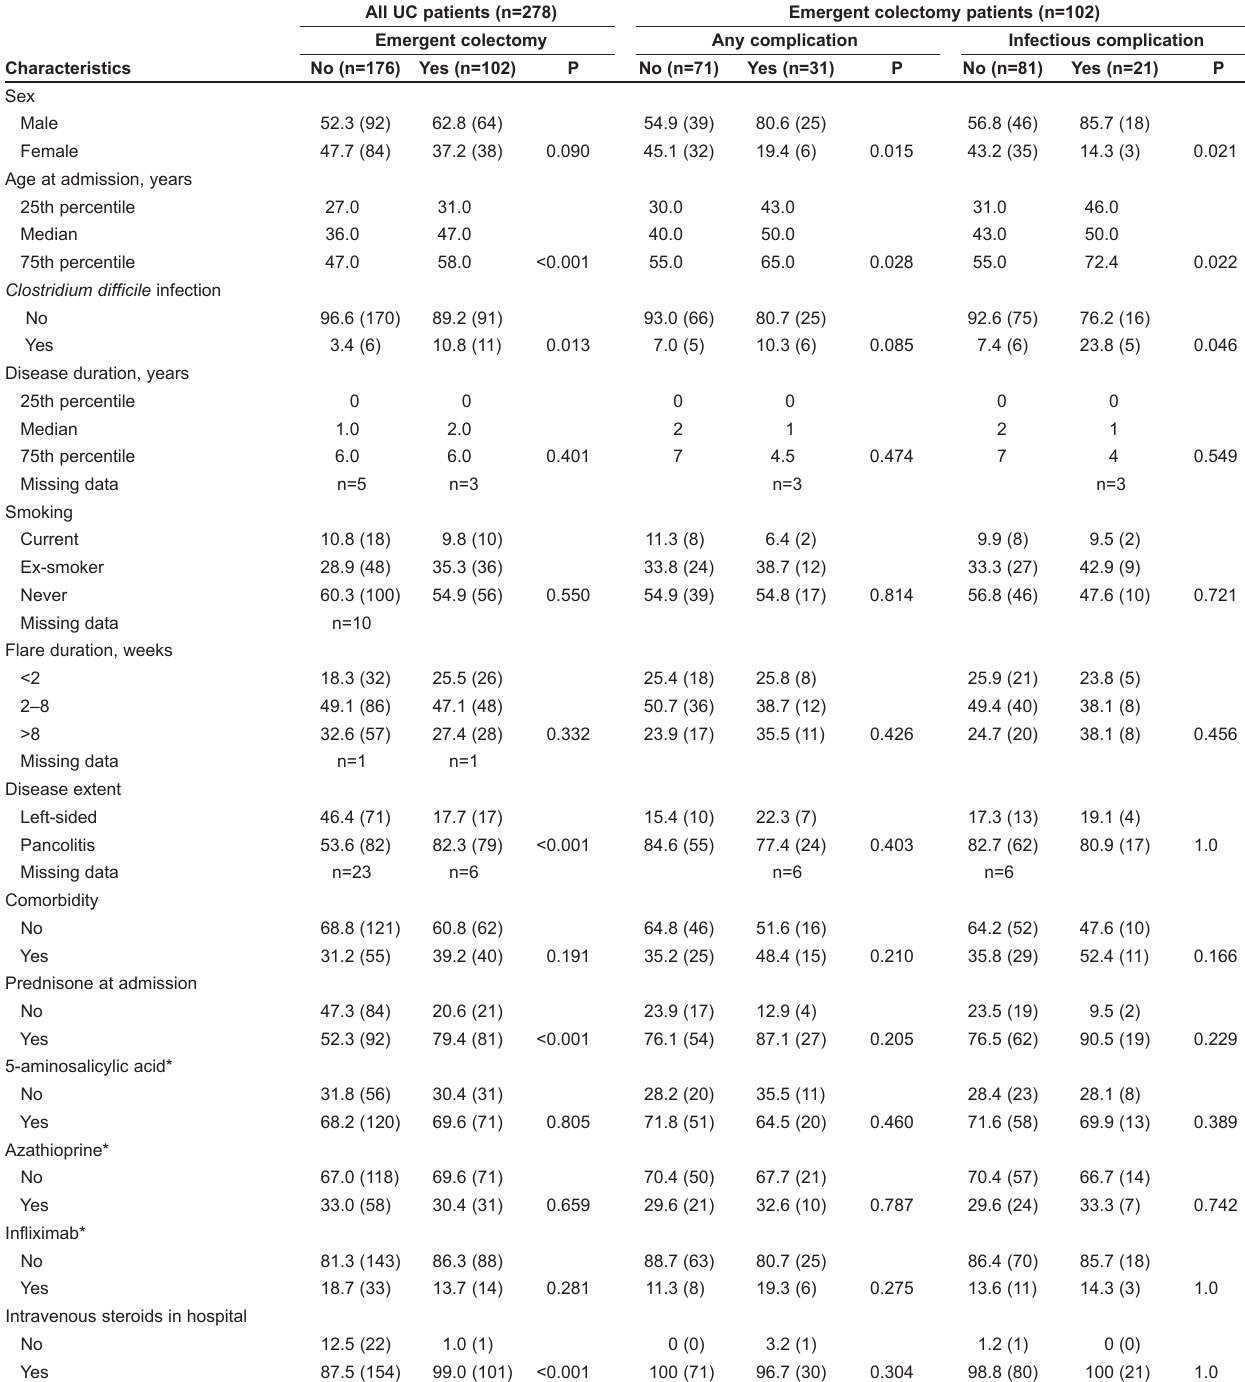
TAble 1 Characteristics of ulcerative colitis (UC) patients admitted to hospital stratified according to flare (medically responsive) and emergent colectomy. emergent colectomy patients were further stratified into development of any